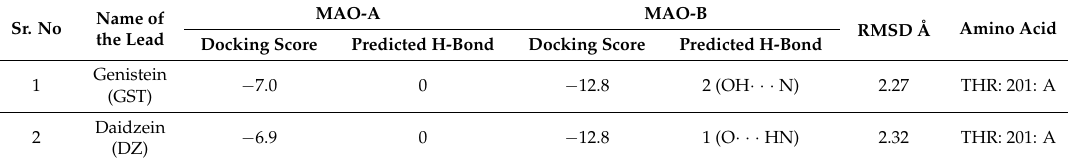
Table 5. Docking scores of isoflavone genistein and daidzein within human monoamine oxidase-A and -B binding